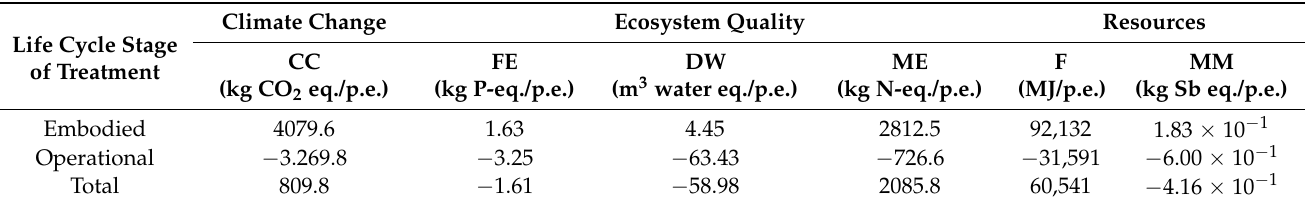
Table 5. Cumulative environmental burdens and breakdown of embodied and operational life cycle impacts per population equivalent (p.e.) for the evapotranspiration treatment system. Life Cycle Stage of